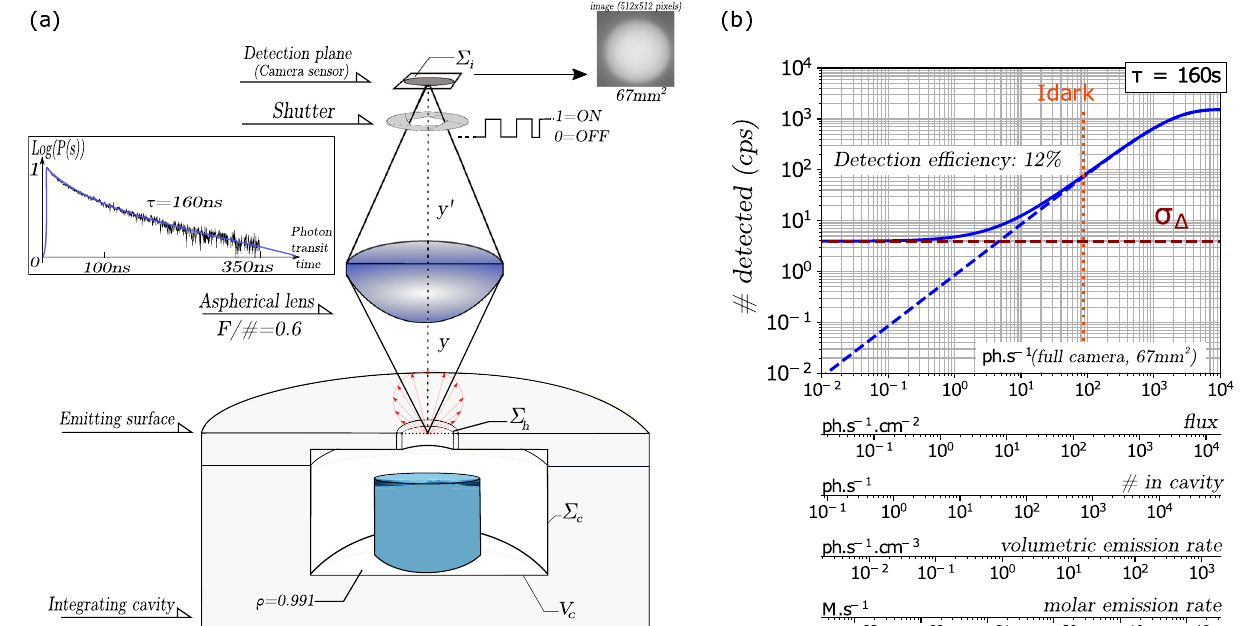
Figure 2. Optical set-up and expected performances. Integrating cavity and optical detection set-up. The set-up 0.29 ), a cooled EM-CCD 5 , ( a ) is made of a cylindrical integrating cavity, a high numerical aperture lens ( NA = and the whole set-up is assembled in a light-proof enclosure (see “Methods”). Cavities made of Teflon or 43cm 3 volume. The intracavity compressed quartz powder had the same 3.8 cm diameter and height, and V C = albedo ρ is assessed from the exponential time-decay P(s) of a short light pulse inside the cavity (insert to ǫ 1 0.991 for Teflon and 0.9994 for quartz. The circular exit port area (cid:31) h 0.6cm 2 matches ( a )). ρ = − = = the fraction ǫ/ρ of the internal area (cid:31) c , i.e., 0.9% for Teflon and 0.06% for quartz. The exit port is imaged on 0.94 using a large lens ( NA 0.29 , φ 40 mm ). With the optimal the detector with a magnification M = = = 50% for any albedo. The probability to reach the detector from port area, the photon exit probability is 1 / 2 ρ ≈ 4.2% whatever the albedo. Under optimal conditions with a fixed hole area, a within the cavity is NA 2 / 2 ρ ≈ larger reflectivity corresponds to a larger cavity area and volume. The EM-CCD detector receives the signal on 0.46cm 2 circular image detection area. Background subtraction between successive frames is done with a (cid:31) d = a shutter. Assuming maximal detection quantum efficiency ( 0.9 ), ( b ) shows the counts per second (cps) on the detector area (cid:31) d as a function of the incident photon rate. The overall detection probability is 4.2% QE ≈ 3.8% . Under optimal exposure τ opt = 160 s 5 , the noise level σ � corresponds to 3.25counts s − 1 (red dotted line). The level ( 3 σ � ) is defined as the limit of detection (LOD) defined by SNR = 3. Additional axes show how the incident photon rate on the detection area translates, into (from top to bottom): the incident flux on the detector, the photon production rate inside the Teflon cavity, the corresponding rate density (volumetric emission rate) in photon s − 1 cm − 3 , and rate density expressed in Molar per second, i.e., moles of photons (Einstein) per liter 3 / 2 ǫ quartz /ǫ Teflon 15 3 / 2 60 for per second or ( E L − 1 s − 1 ). Since the LOD is enhanced by a factor [ ] − = ≈